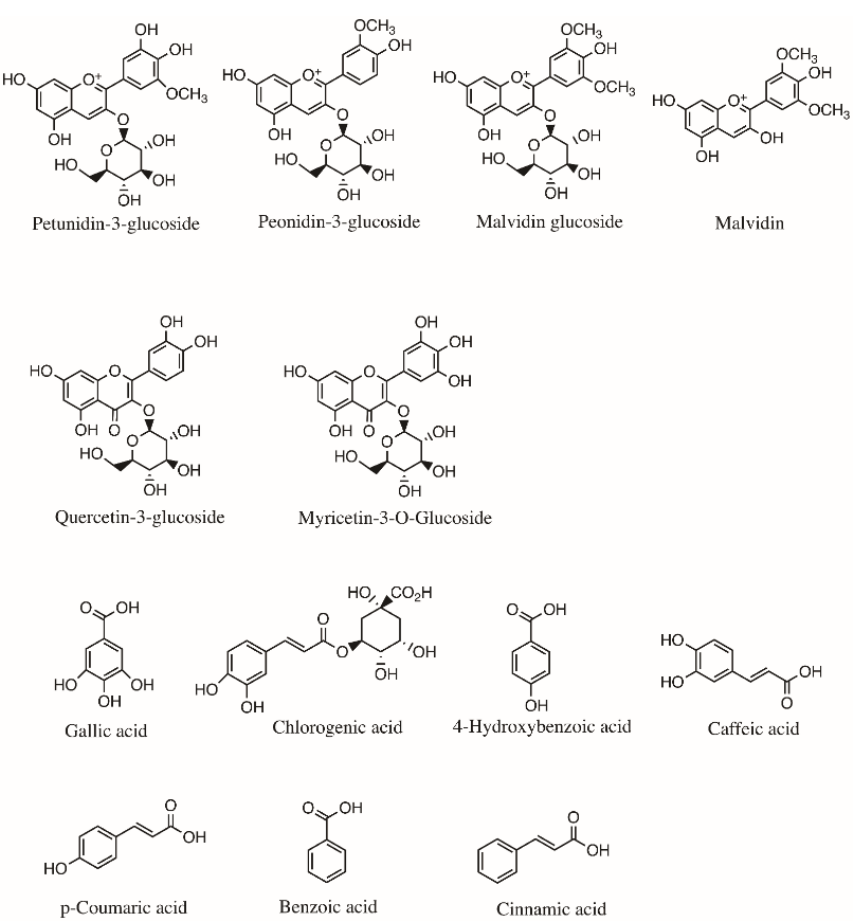
Figure 3. Chemical structures of the phenolic compounds detected by HPLC-DAD in País grape juice obtained by steam extraction.